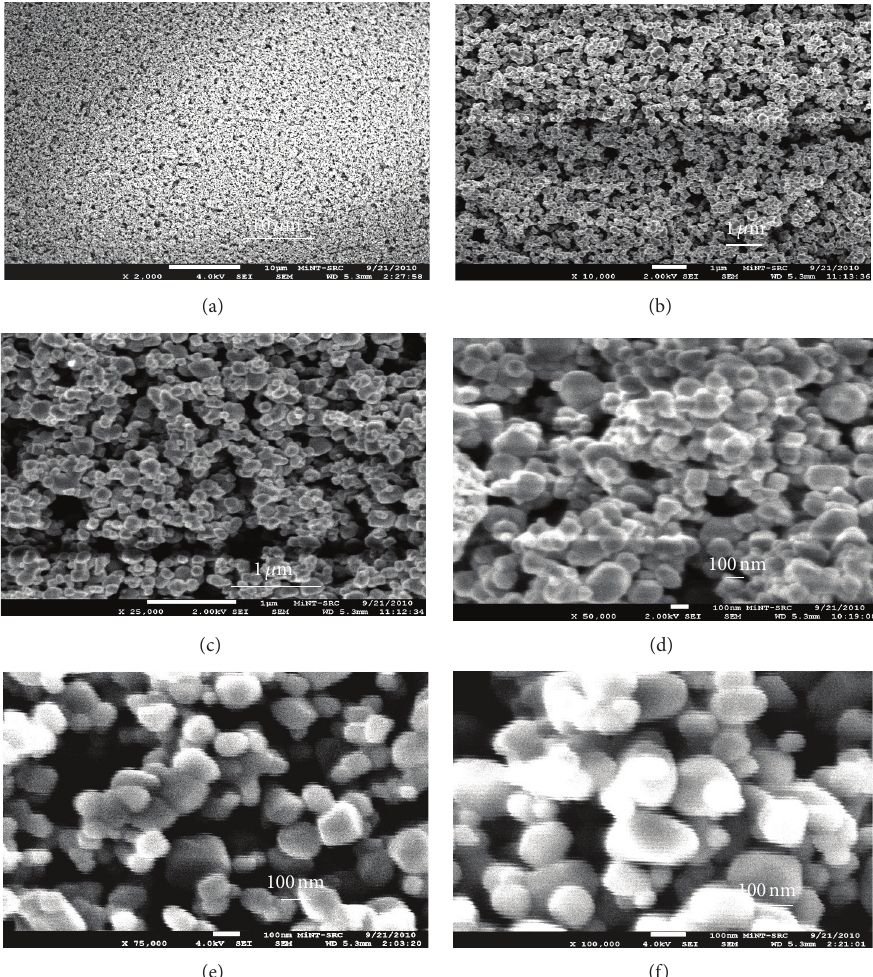
Figure 3: Metal oxide morphology with magnification for untreated TiO 2 , (a) 2000, (b) 10000, (c) 25000, (d) 50000, (e) 75000, and (f)